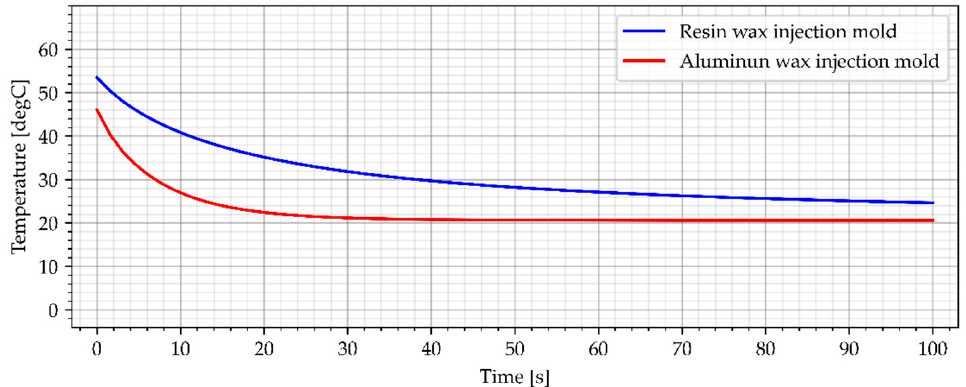
Figure 15. The average temperature of the sample for wax injection molds without cooling